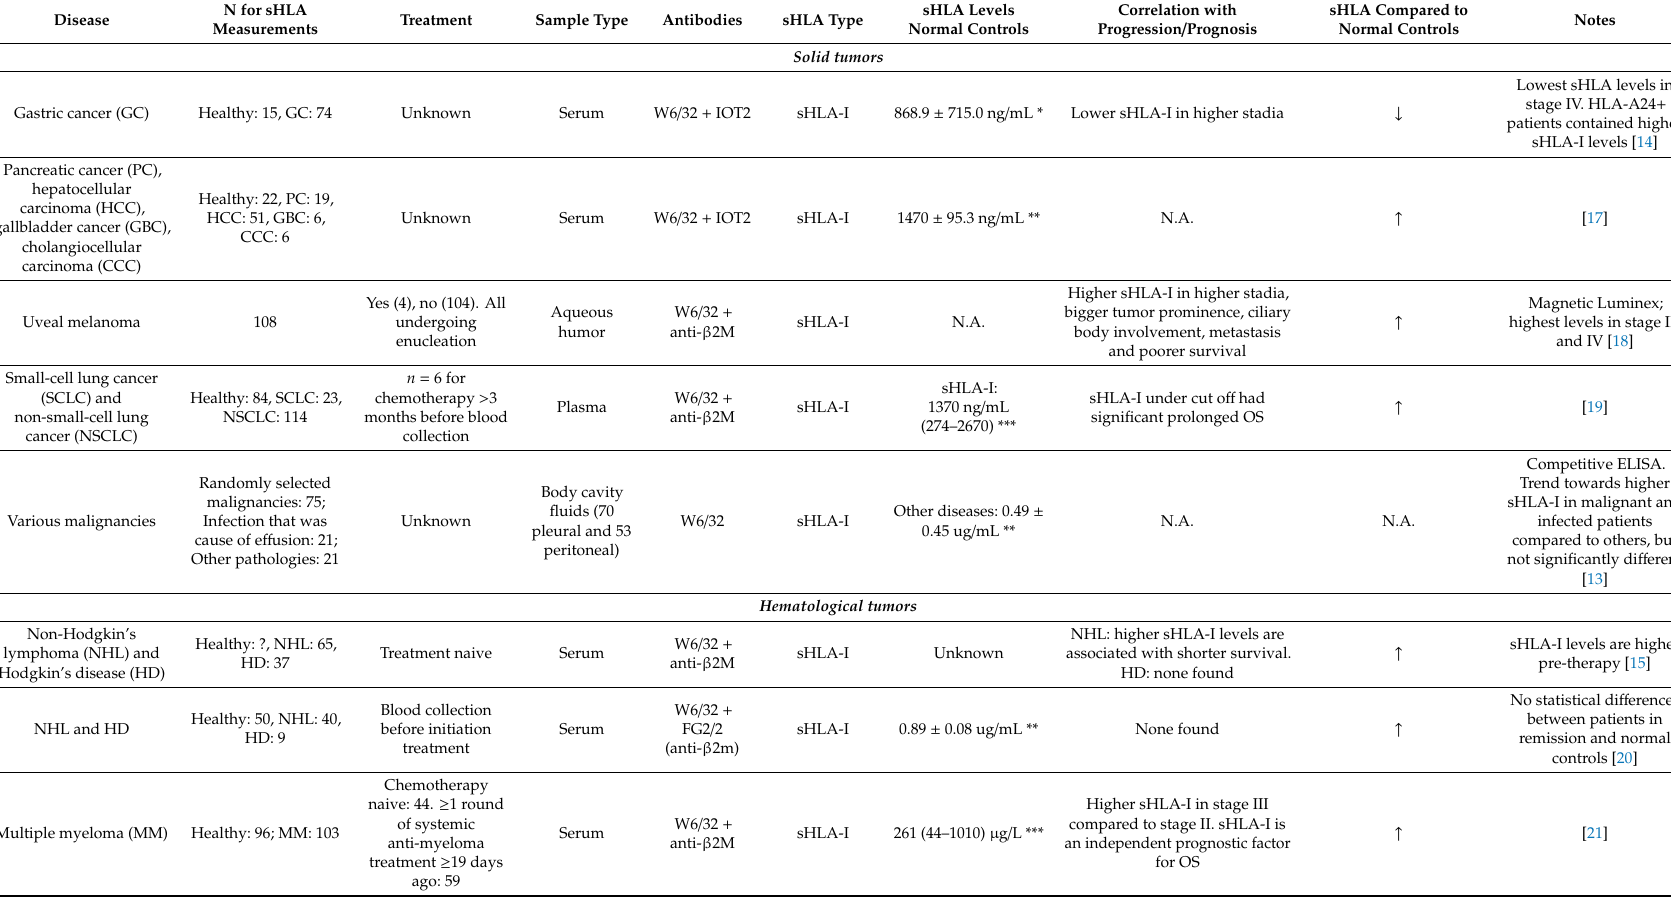
Table 1. Soluble HLA Class I Molecules in Malignancy . Levels of soluble HLA class I molecules in various solid and hematological tumors. All studies measured sHLA levels by ELISA, unless indicated otherwise under Notes. * = mean ± SD, ** = mean ± SE, *** = median (range), **** = median [interquartile